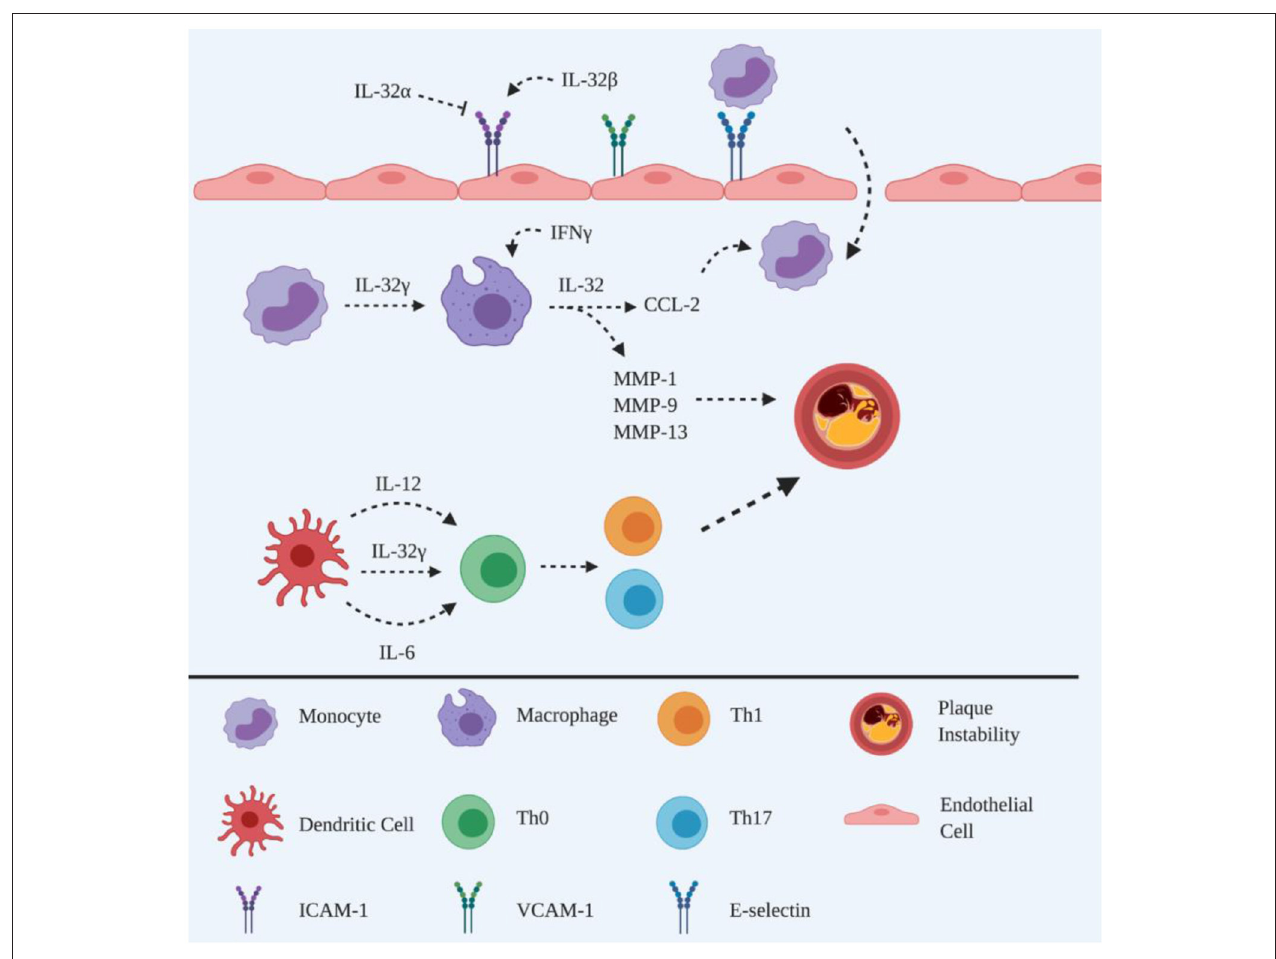
FIGURE 1 | Schematic representation of the roles of IL-32 in atherogenesis. Adhesion molecules are promoted by IL-32 β to facilitate monocyte recruitment, whereas recruitment can also be inhibited by IL-32 α . The differentiation of monocytes into phagocytic macrophages is induced by IL-32 γ , which in turn triggers the release of CCL-2 to recruit circulating monocytes. IL-32 γ induces the maturation of DCs, releasing IL-12 and IL-6 to polarise naïve CD4 + T cells into Th1 and Th17 subsets. IL-32 γ induces macrophages to produce MMPs leading to atherosclerotic plaque instability. Created with